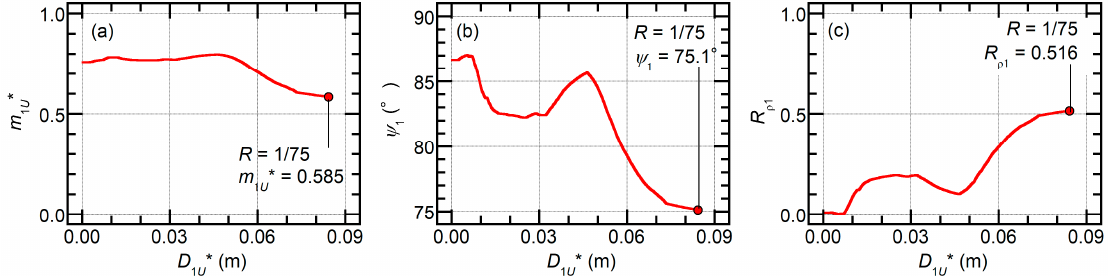
Figure 16. Variations in the first mode parameters based on the pushover analysis: ( a ) effective modal mass ratio ( m 1 U * ), ( b ) incidence angle of the principal axis of the first modal response ( ψ 1 ), and ( c ) torsional index of the first mode ( R ρ 1 ).